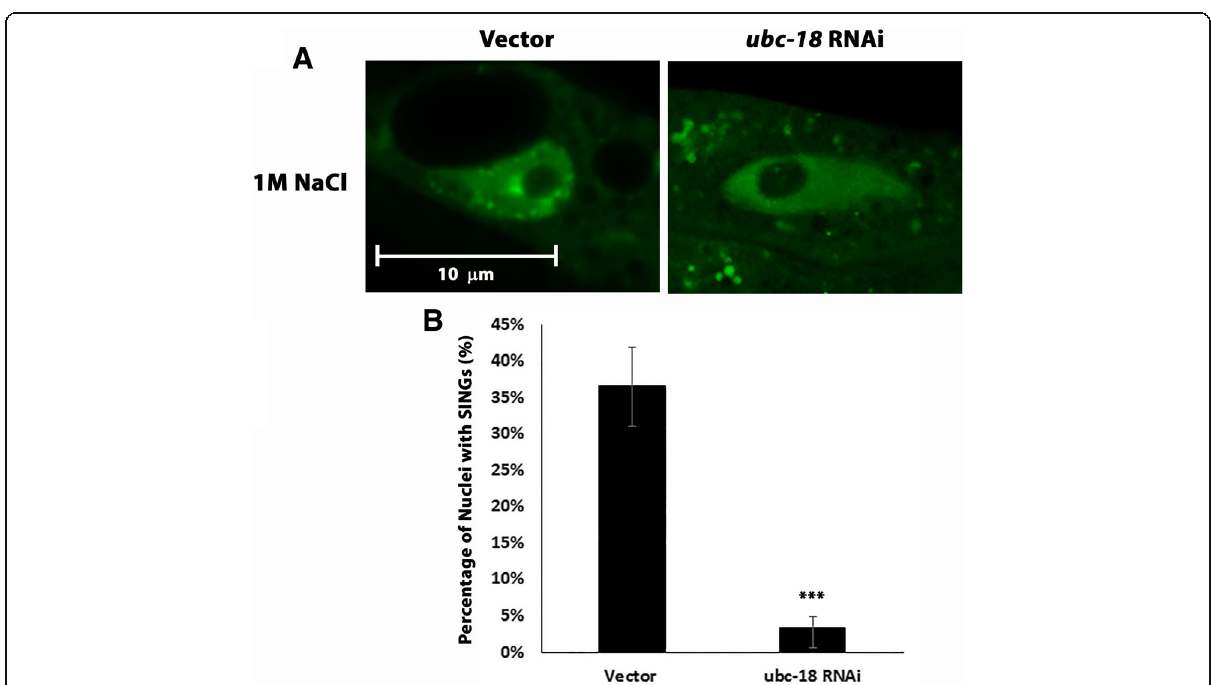
Fig. 7 SINGs form in intestinal cells. a A strain expressing GFP::Ub in intestinal cells was soaked in 1 M NaCl for 1 h prior to imaging with a laser scanning confocal microscope. The salt stress induced SING formation in intestinal nuclei. Worms that had been grown under ubc-18 ( RNAi ) did not form SINGs upon salt stress. b Quantification of the intestinal nuclear response to salt stress. Three trials were done for each condition including 10 worms per trial and 10 intestinal nuclei per worm ( n = 30 worms). Statistical significance was calculated by a Fisher ’ s Exact test: *** p